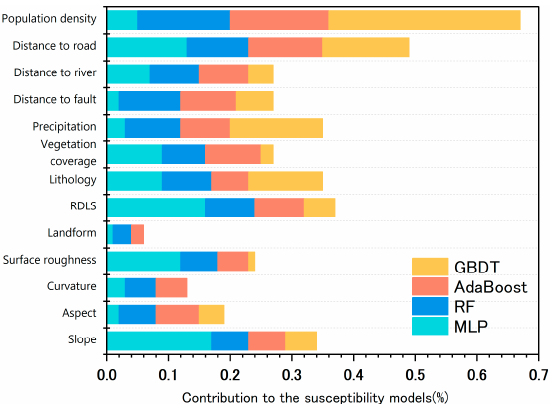
Figure 7. Relative importance of conditioning factors in the four